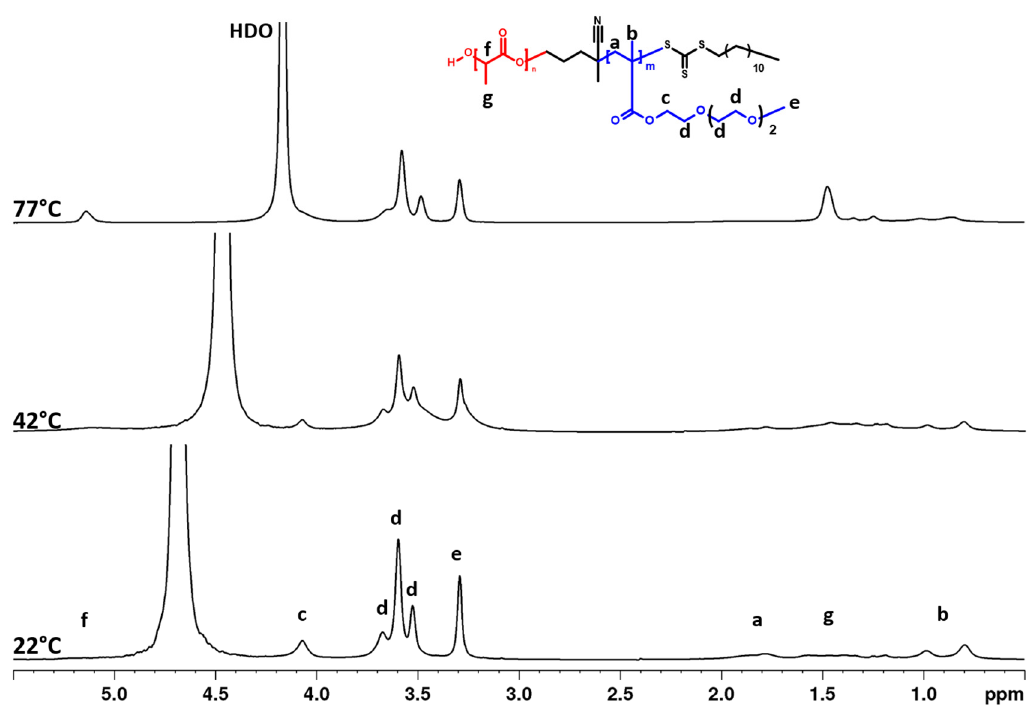
Figure 5. 1 H NMR spectra of PLA- b -PTEGMA (BC2) NPs in D 2 O solution (c = 2.8 mg·mL − 1 ) measured at 22, 42, and 77 °C under the same instrumental conditions.